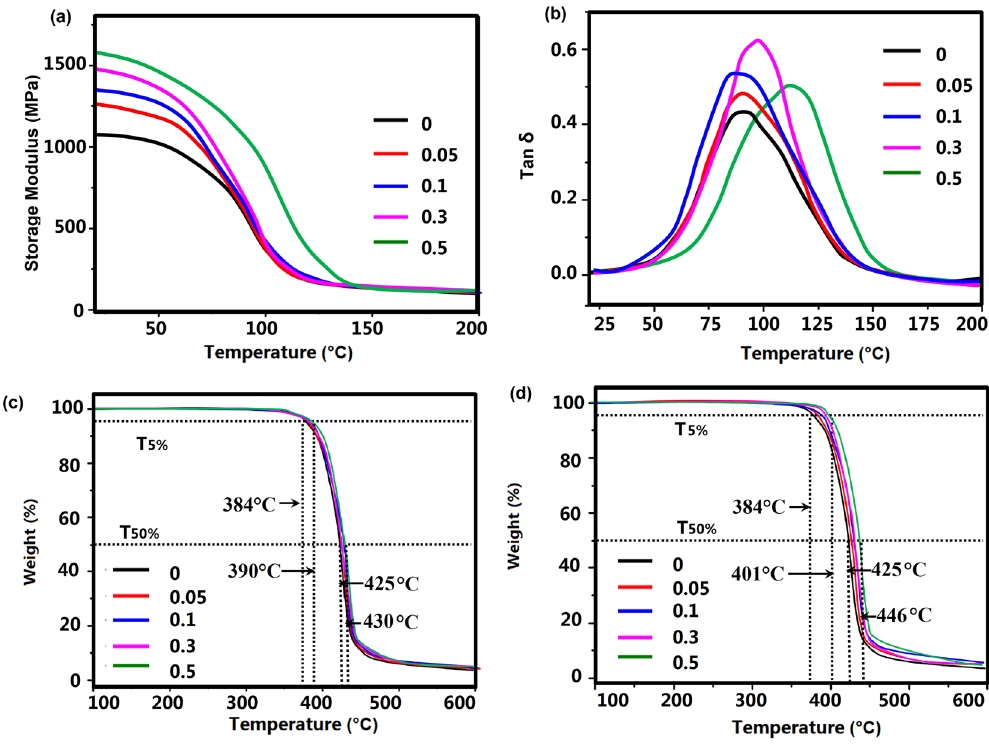
Figure 5. Dynamic mechanical properties of bGO/BFDE composite ( a , b ); TGA curves of neat BDFE epoxy ( c ) and bGO/BFDE composite ( d